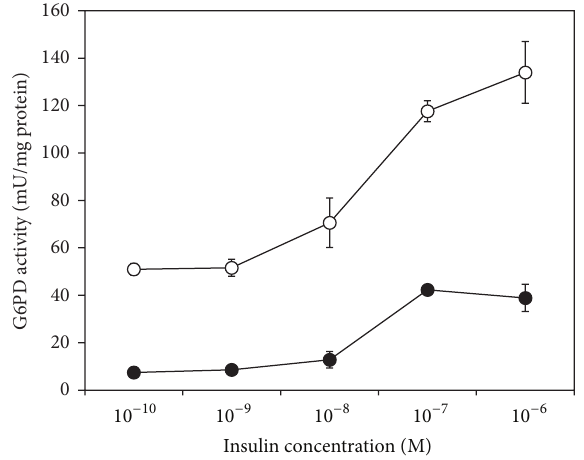
Figure 5: Amplifying insulin response for G6PD activity and effect of BSO. Precultured isolated hepatocytes were incubated for 48 h in thebasalWEmediumasdescribedinFigure4.Tothebasalmedium, insulin at a series of concentrations (10 −10 to 10 −6 M) was added, and G6PD activity was determined in the presence (closed circle) and absence (open circle) of 0.1 mM